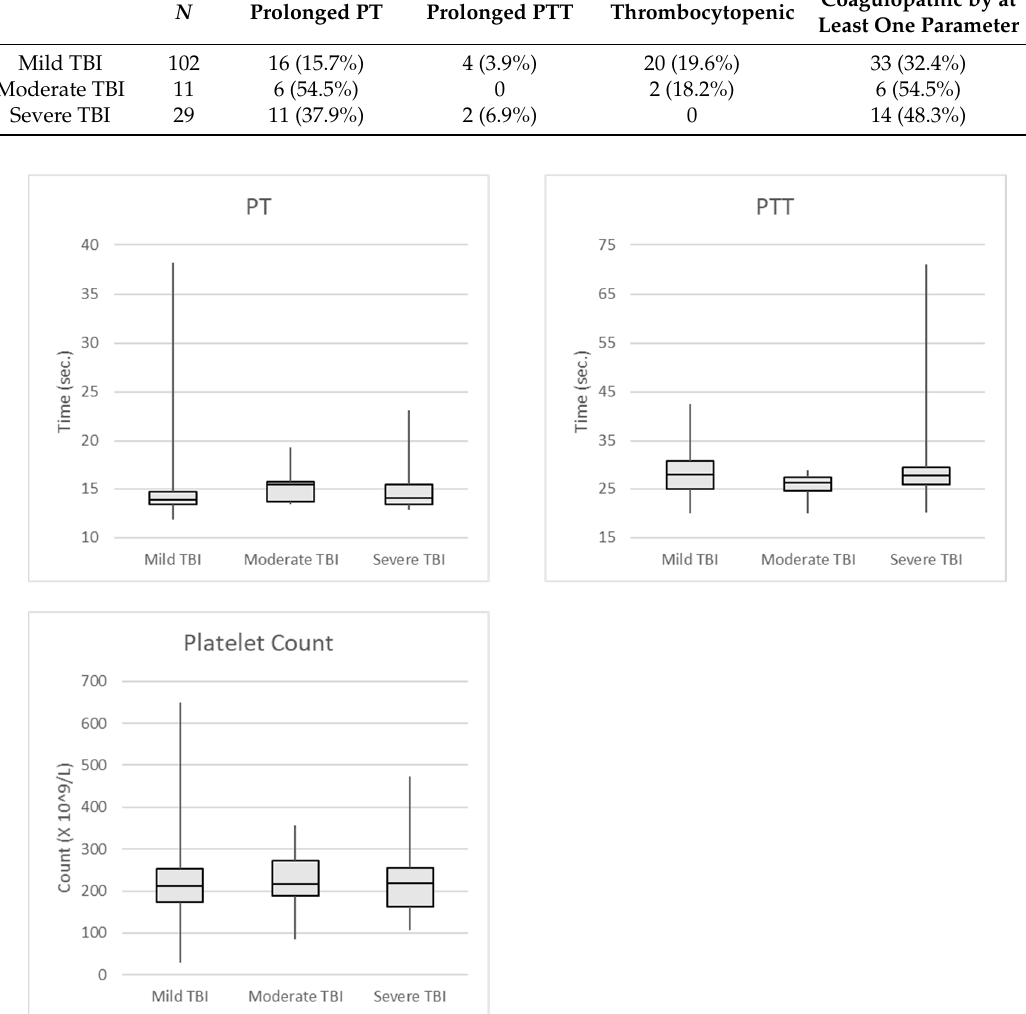
Figure 1. PT, PTT, and platelet count in all TBI Patients.